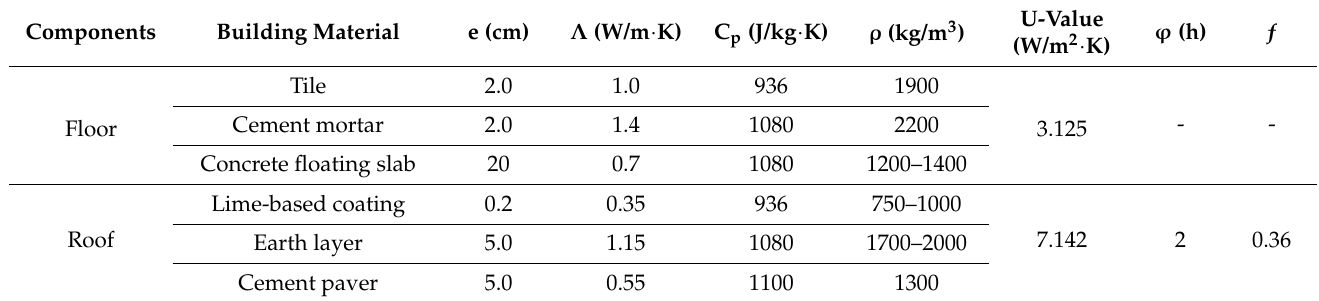
Figure 6. Instruments of measurement.